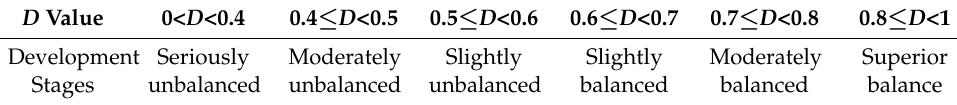
Table 1. Coupling coordination degree and its classification